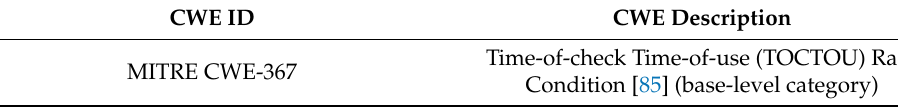
Table 6. Race condition.